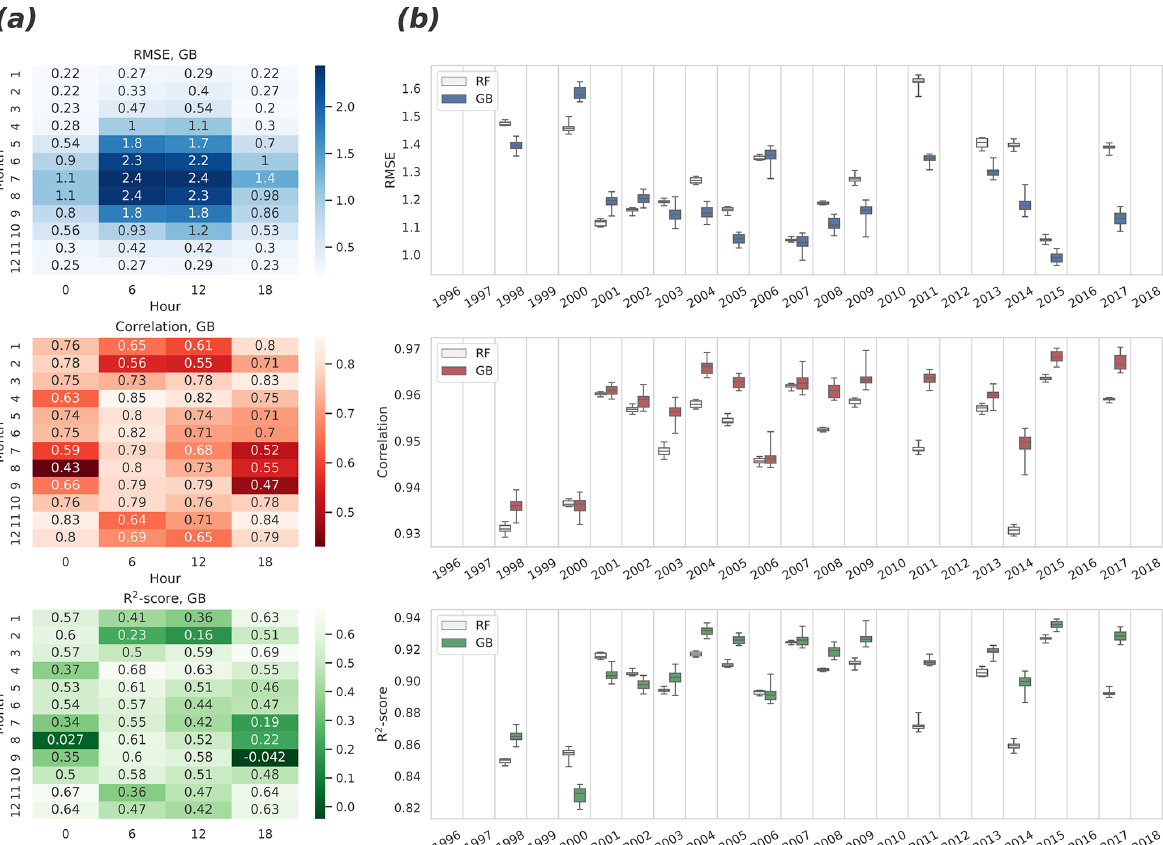
Figure 4. Estimates of the root mean square error (upper panels), the Pearson correlation coefficient (center panels), and the R 2 score (bottom panels) derived from the eight repeated representations of the cross-validated time series. (a) Monthly and 6h decompositions of RMSE, correlation, and R 2 for GB. Median values of quantities are shown, calculated from differently repeated cross-validation experiments. (b) Annual variability of RMSE, correlation, and R 2 for the RF and GB: variability shown in boxes was calculated from differently repeated cross-validation experiments. Median is shown with a horizontal line in the center of each box. Quartiles are shown with box edges and minima/maxima with whiskers. Years with more than 40% of missing data were excluded.